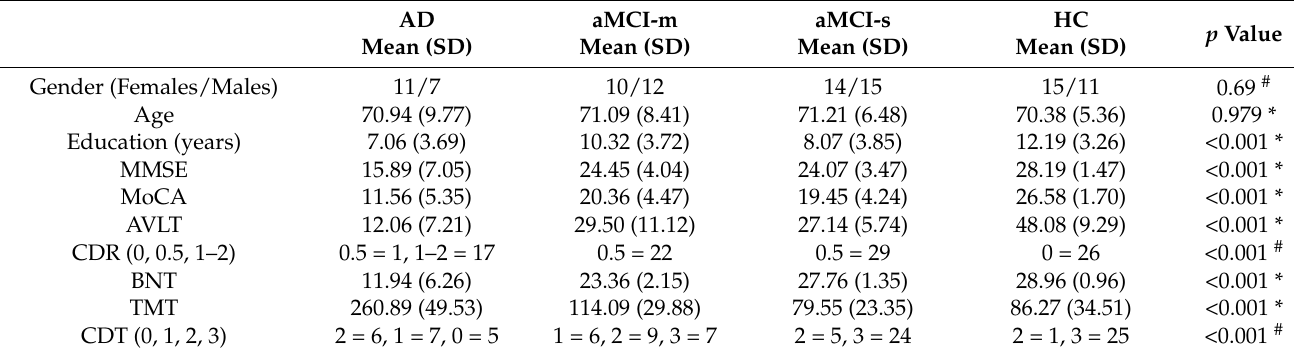
Table 1. Demographic and neuropsychological assessments of